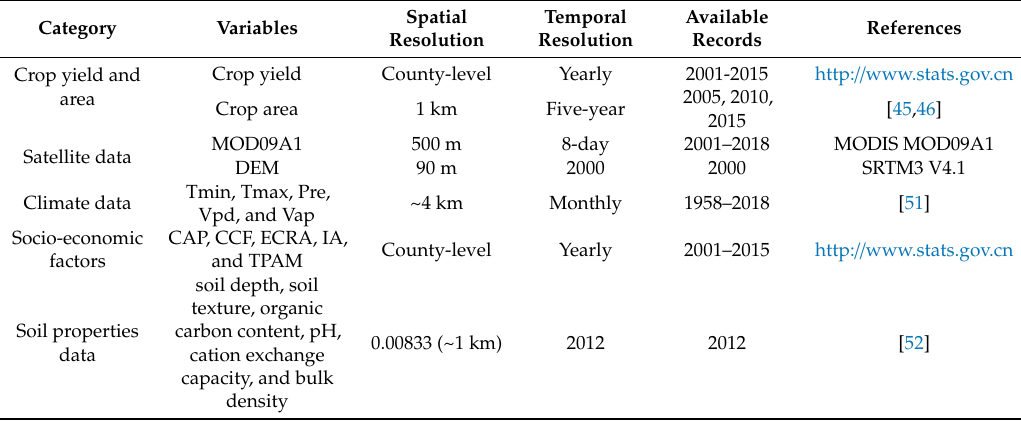
Table 1. Summary in the collected datasets for winter wheat yield prediction in China. The Tmax, Tmin, Pre, Vpd, and Vap refer to maximum temperatures ( ◦ C), minimum temperatures ( ◦ C), precipitation (mm), vapor pressure deficit (kPa), and vapor pressure (kPa), respectively; IA, CCF, CAP, TPAM, and ECRA refer to the irrigation area (ha), the consumption of chemical fertilizers (ton), the consumption of agricultural pesticide (CAP), the total power of agricultural machinery (TPAM), and the electricity consumed in rural areas (ECRA),